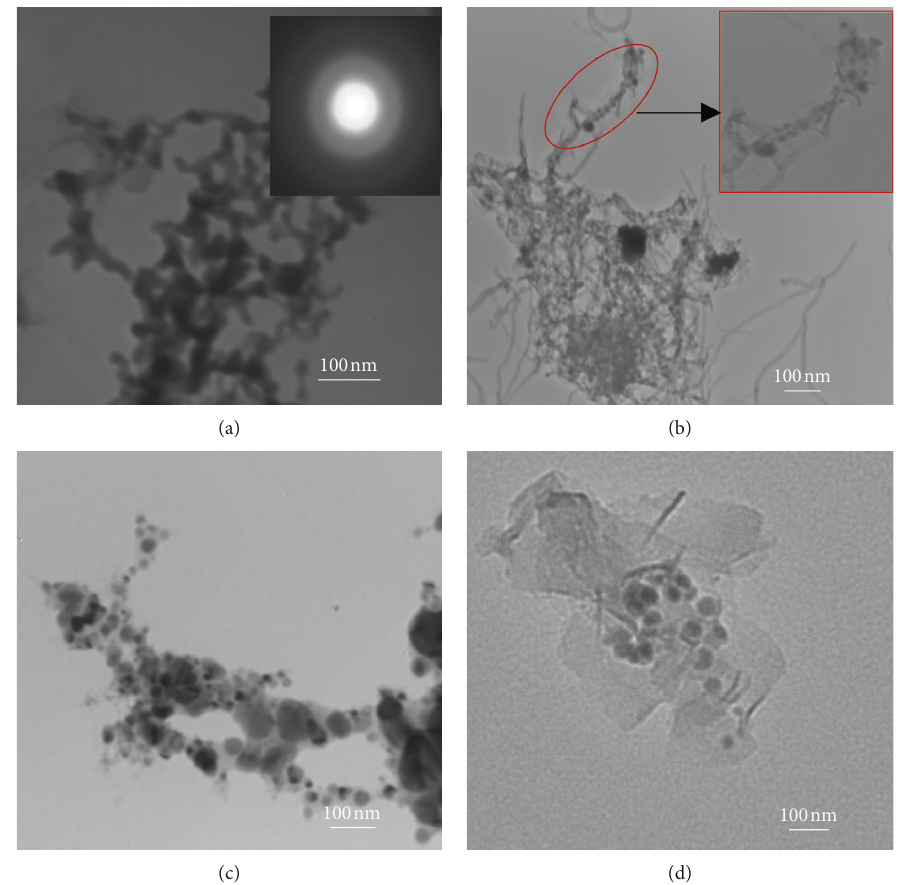
Figure 2: TEM images of the amorphous alloy NiB and its supported catalysts. (a) NiB; (b) NiB/CNTs; (c) NiB/SiO